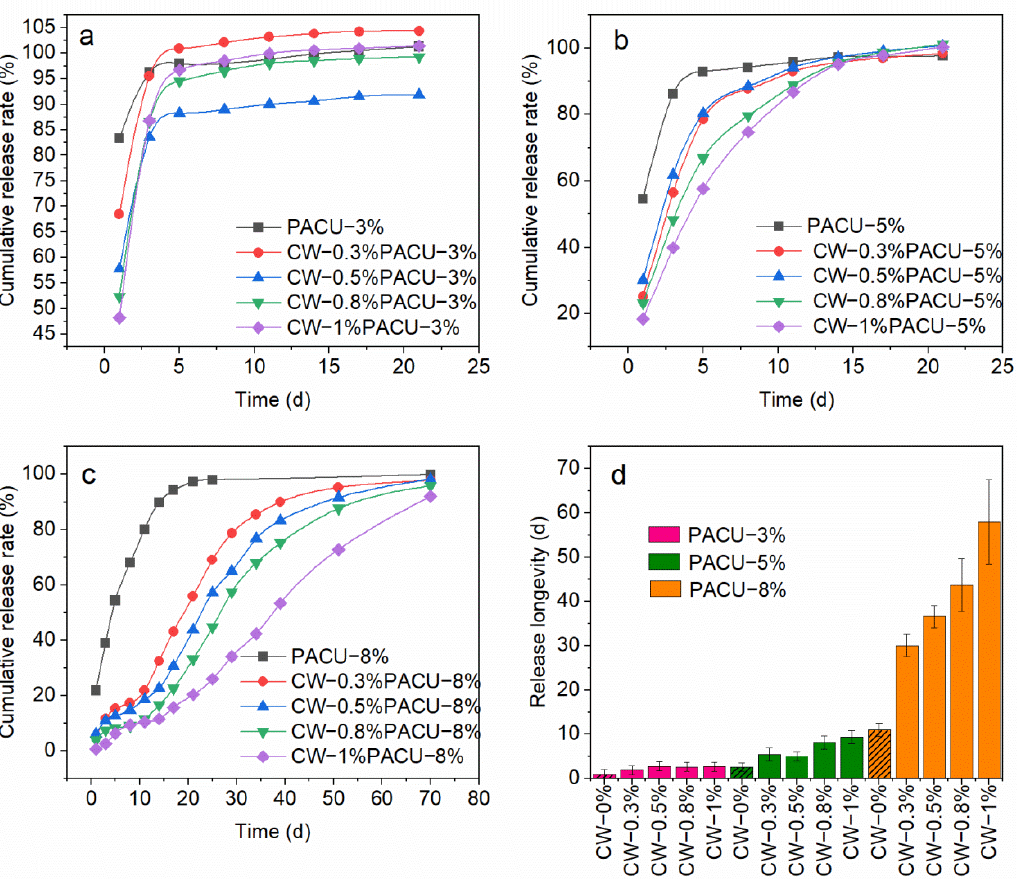
Figure 6. Release performance of coated urea with different Carnauba wax (CW) and WPA contents. ( a ) Urea coated with 3% WPA (PACU-3%). ( b ) Urea coated with 5% WPA (PACU-5%). ( c ) Urea coated with 8% WPA (PACU-8%). ( d ) Comparison of release longevity (80%) between different